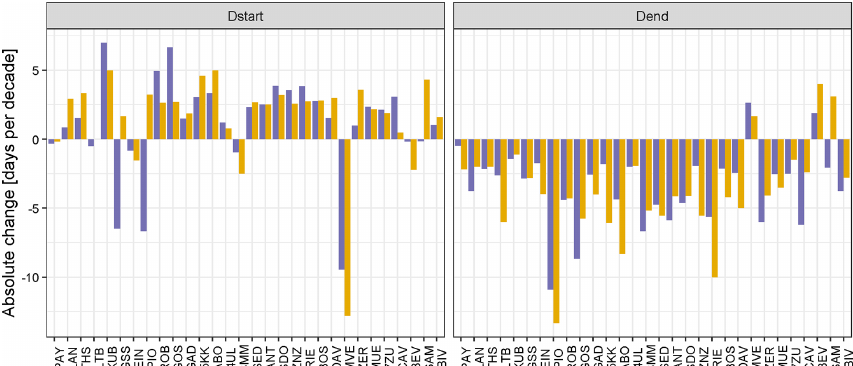
Figure 5. Absolute changes of snow onset (Dstart) and disappearance (Dend) dates calculated for all available parallel periods and expressed as days per decade. Station pairs are ordered according to elevation from left to right. Yellow and purple bars indicate individual stations within a